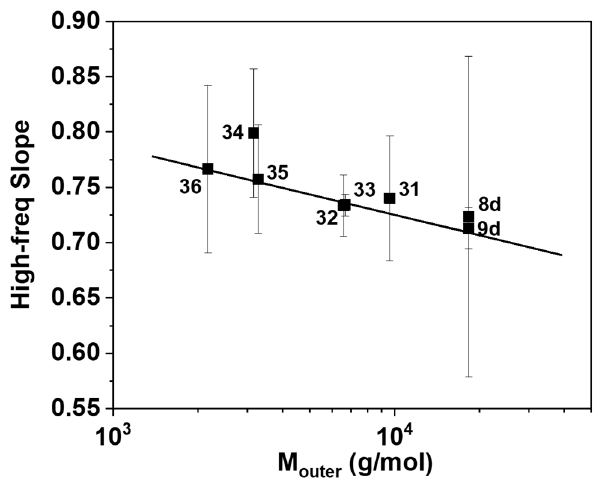
Figure 2. The high-frequency slope as function of outer ring molecular weight M outer . The solid curve is a linear fit with slope − 0.06. Here, the molecular weight of PSTY-8d is treated as M outer . Error bars reflect standard deviations from each fit.